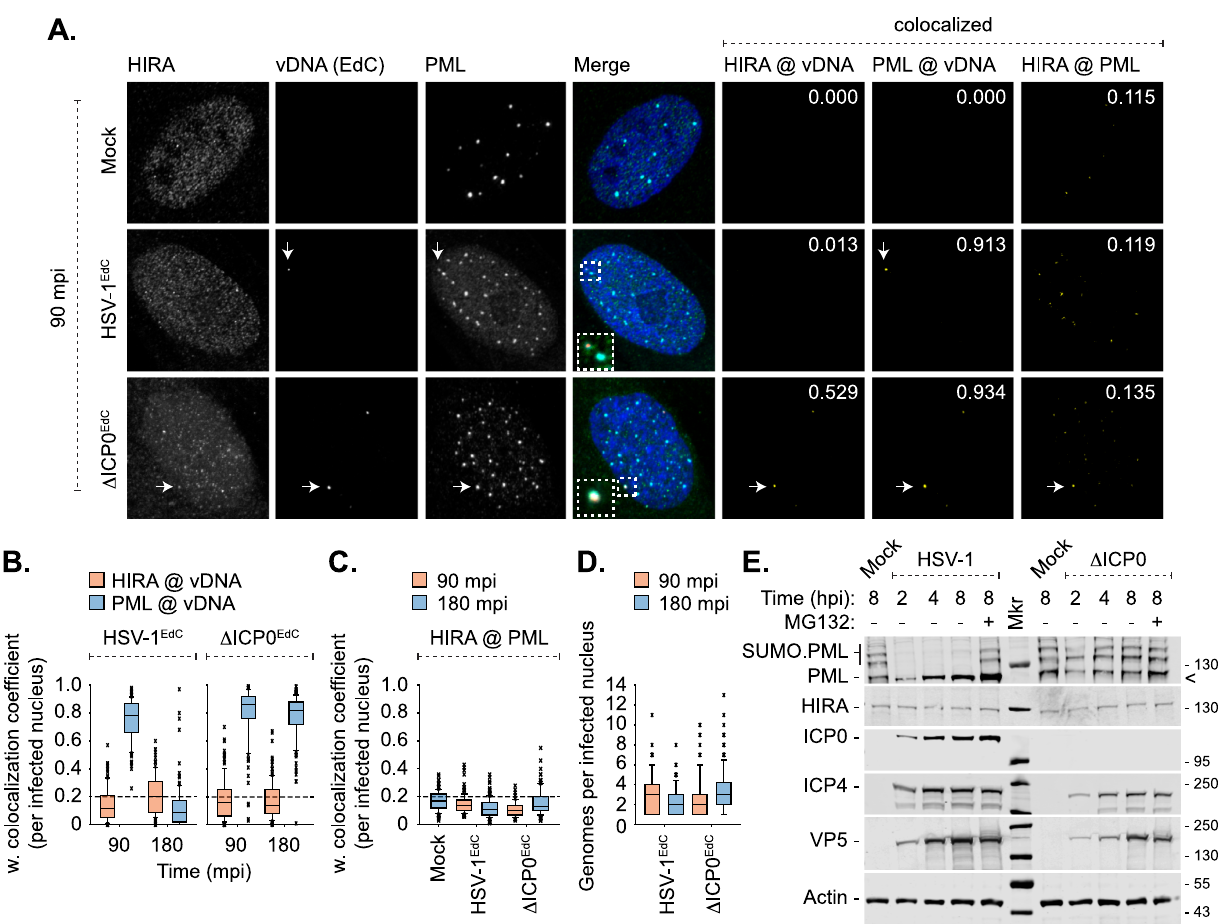
Fig 1. Nuclear entry of HSV-1 genomes is not sufficient to induce HIRA localization at PML-NBs. HFt cells were mock infected or infected with 3 PFU/cell of HSV-1 EdC or Δ ICP0 EdC . Cells were fixed and permeabilized at 90 or 180 minutes post-infection (mpi; post-addition of virus). Infecting EdC labelled viral DNA (vDNA) was detected by click chemistry [9]. HIRA and PML were detected by indirect immunofluorescence. (A) Sub-nuclear localization of HIRA (green) and PML (cyan) with respect to infecting HSV-1 EdC or Δ ICP0 EdC vDNA (red, white arrows) at 90 mpi. Insets show magnified regions of interest (dashed boxes). Cut mask (yellow) highlights regions of colocalization between cellular proteins of interest and vDNA or cellular proteins of interest only (as indicated). Weighted colocalization coefficients shown. Nuclei were stained with DAPI (blue). (B, C) Quantitation of cellular protein recruitment to infecting vDNA (B) or HIRA colocalization with PML in mock, HSV-1 EdC , or Δ ICP0 EdC infected nuclei (C) at 90 or 180 mpi (as indicated). (D) Genome copy number per infected nuclei at 90 or 180 mpi. Boxes: 25 th to 75 th percentile range; black line: median weighted (w.) colocalization coefficient; whiskers: 5 th to 95 th percentile range; crosses: outliers; dashed line: coincident threshold (weighted colocalization coefficients < 0.2). n � 100 nuclei per sample population derived from a minimum of three independent infections. (E) HFt cells were mock, WT, or Δ ICP0 HSV-1 infected with 10 PFU/cell in the absence or presence of the proteasome inhibitor MG132 (5 μ M; -/+, as indicated). Whole cell lysates were collected at the indicated times for western blot analysis to monitor PML and HIRA stability during HSV-1 infection and the accumulation of viral immediate early (IE; ICP0, ICP4) and late (L; VP5) proteins. Actin is shown as a loading control. Molecular mass markers are shown (Mkr), < denotes the detection of a non-specific background